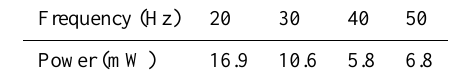
Table 1. Generator output power over Frequency.